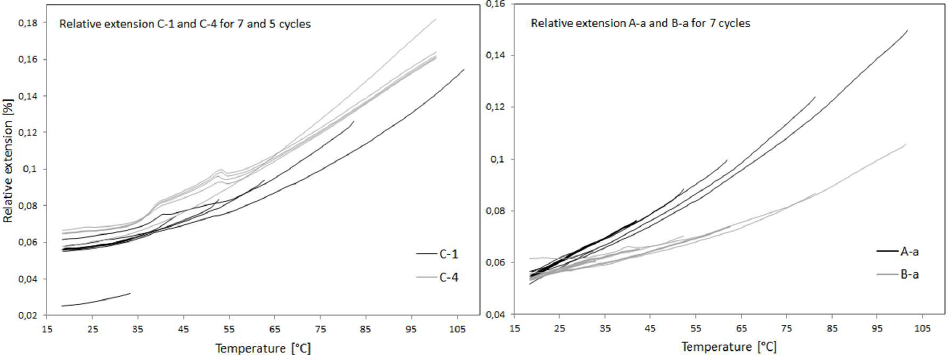
Figure 4. Dependence of relative extension on the temperature.